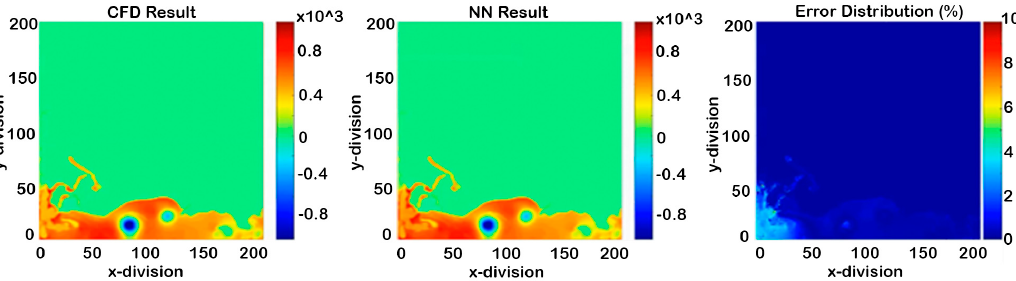
Figure 20. Non-cascading result of pressure at the maximum error in the whole process (2.604 s). For starting the deployment of the cascading condition, all of the variables from CFD could be used. To have the same condition for all models, we started the deployment from time-step 1000 to see how many time-steps would be predicted.